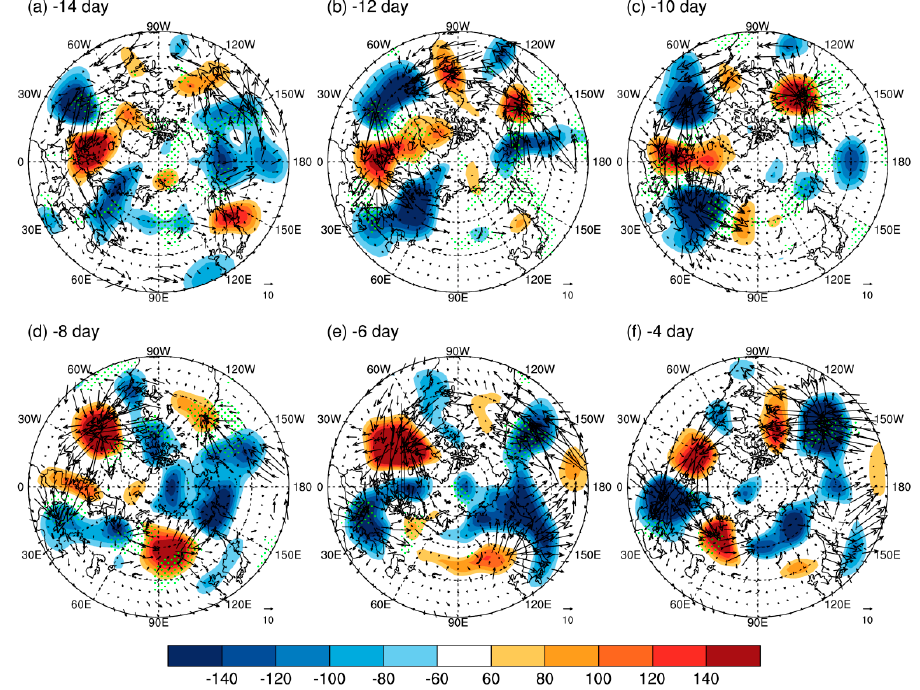
Figure 9. Composite GPH anomalies at 300 hPa (shaded areas; unit: m; significant values at the 0.05 confidence level are presented by green dots) and Plumb wave action flux anomalies (vectors, unit: m 2 /s 2 ) from day − 14 to day − 4 ( a–f ) relative to the north cold surge occurrences.